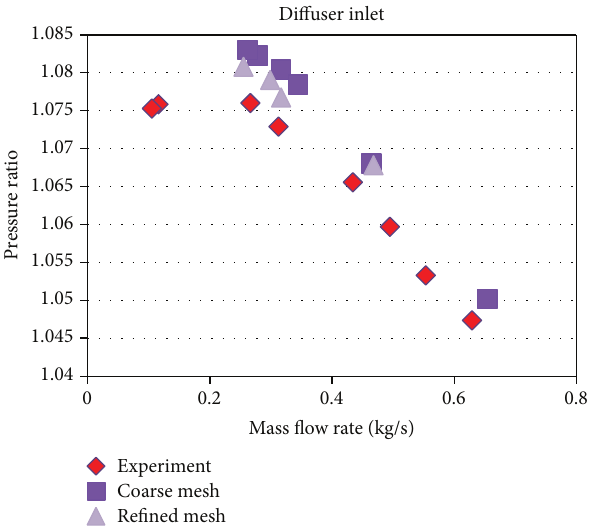
Figure 15: Pressure characteristic at the diffuser inlet for the unsteady case in the diffuser